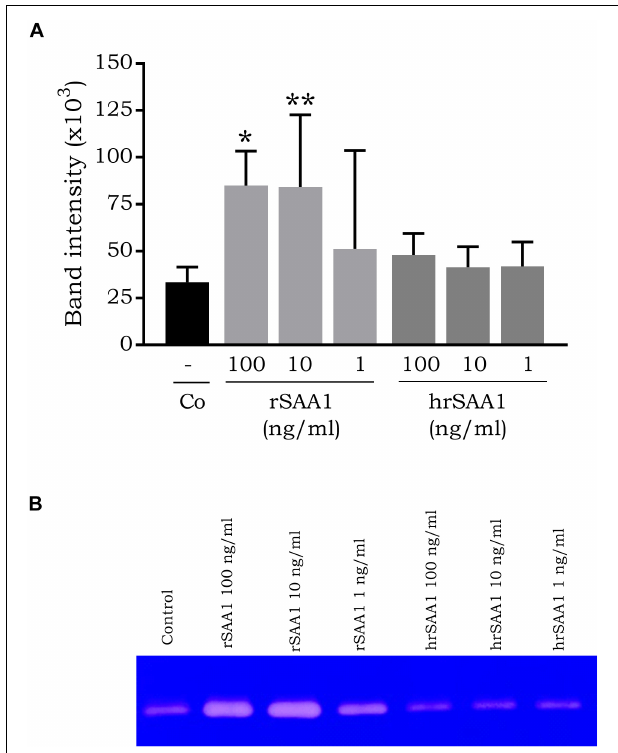
FIGURE 4 | hrSAA1 does not induce MMP-9 expression in CD14 + monocytes. Freshly isolated monocytes were induced with homogenous rSAA1 (hrSAA1) (1–100 ng/ml, 0.08–8 nM) in parallel with rSAA1 (1–100 ng/ml, 0.08–8 nM). Following an incubation period of 24 h, cell supernatants were collected and MMP-9 expression was determined via zymography. (A) Results are represented as the mean band intensity ( × 10 3 ) + SEM and are derived from four to six independent experiments. Significant upregulation in comparison to control is indicated by asterisks (Mann-Whitney U -test; * p -value < 0.05, ** p -value < 0.01). (B) One representative zymography is shown.